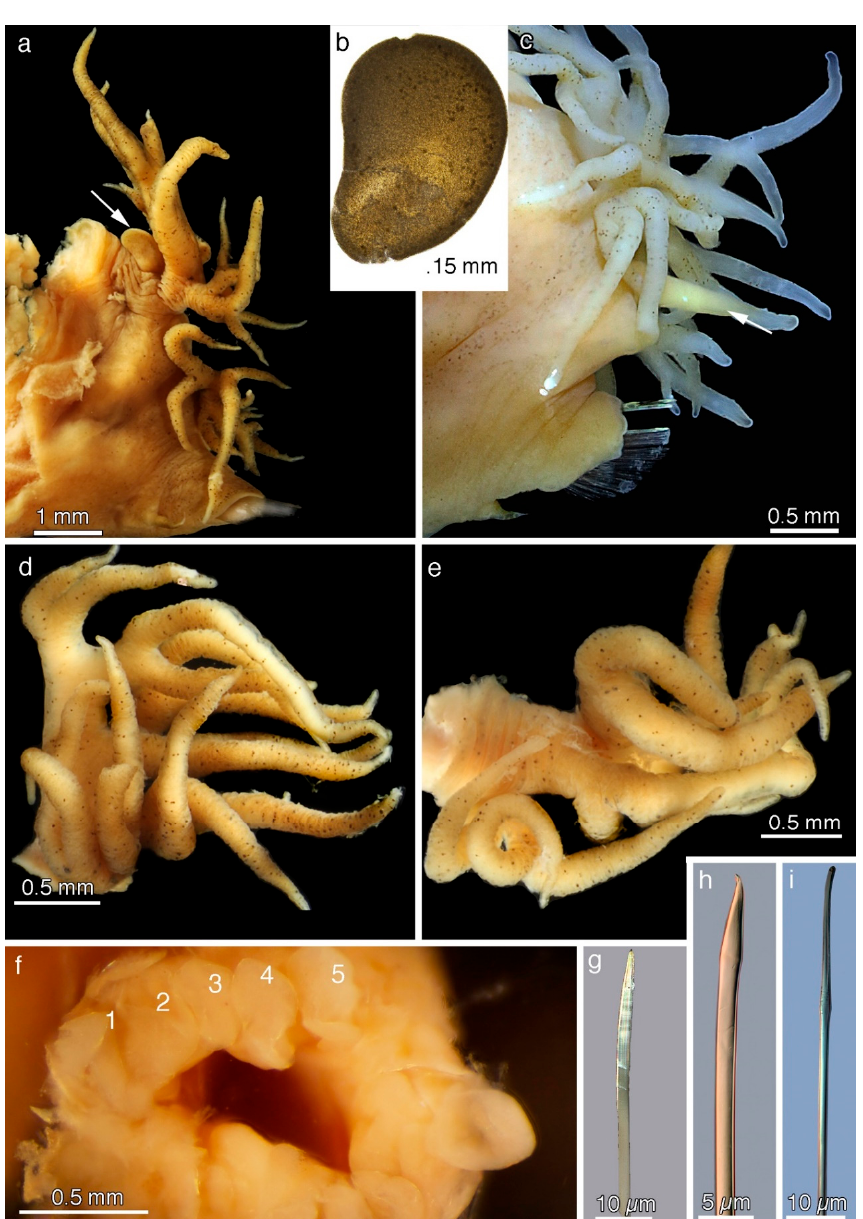
Figure 16. Branchipolynoe meridae n. sp. preserved female paratypes (all SIO-BIC A6521, except for proboscis): ( a ). Parapodium from Segment 15 with elytron (arrow). ( b ). Elytron from Segment 13. ( c ). Parapodium from Segment 8 with dorsal cirrus (arrow). ( d ). Branchia from Segment 12 (dorsal group). ( e ). Branchia from Segment 12 (ventral group). ( f ). Frontal view of proboscis showing papillae (MZUCR 404-02). ( g ). Notochaeta (Segment 16). ( h ). Supra-acicular neurochaeta (Segment 8). ( i ). Subacicular neurochaeta (Segment 8).